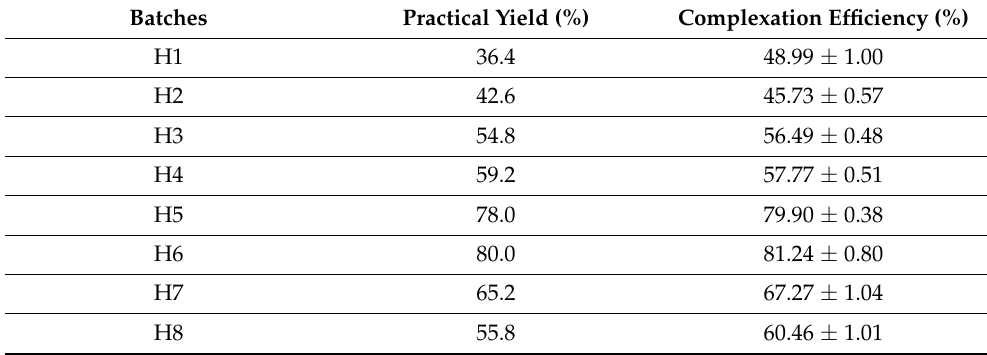
Table 2. Practical yield and complexation efficiency of nanophytophospholipid batches of SIL.